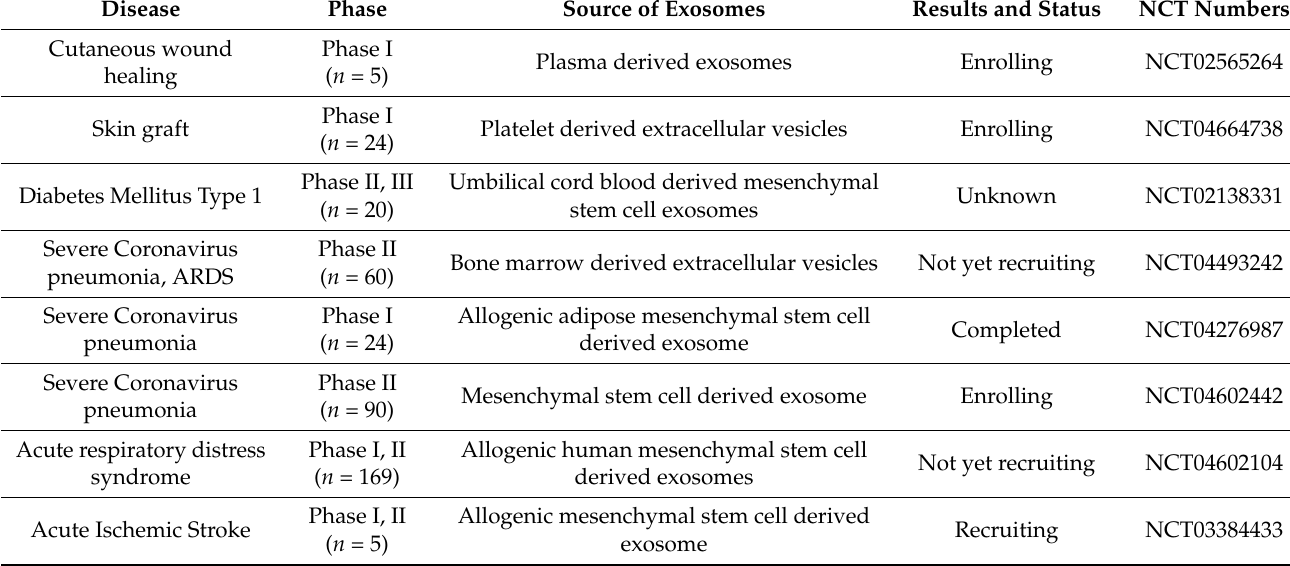
Table 2. Human clinical trials of EVs in inflammatory